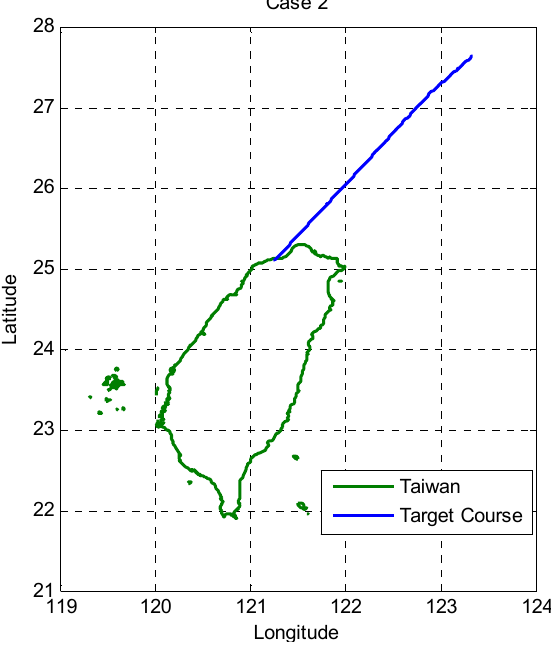
Figure 4. Flight path for Case 2 (target flying away from Taiwan).